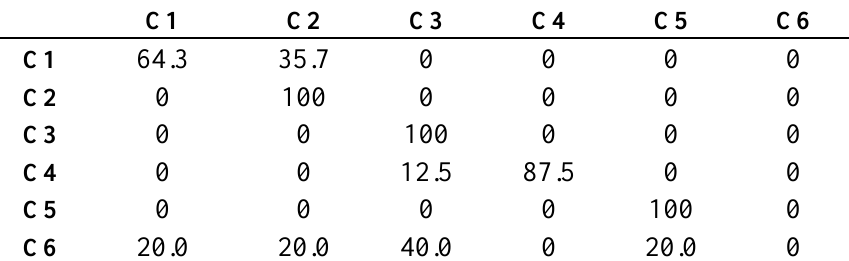
Table 8. Confusion matrix for LoMoCo model (Unit: